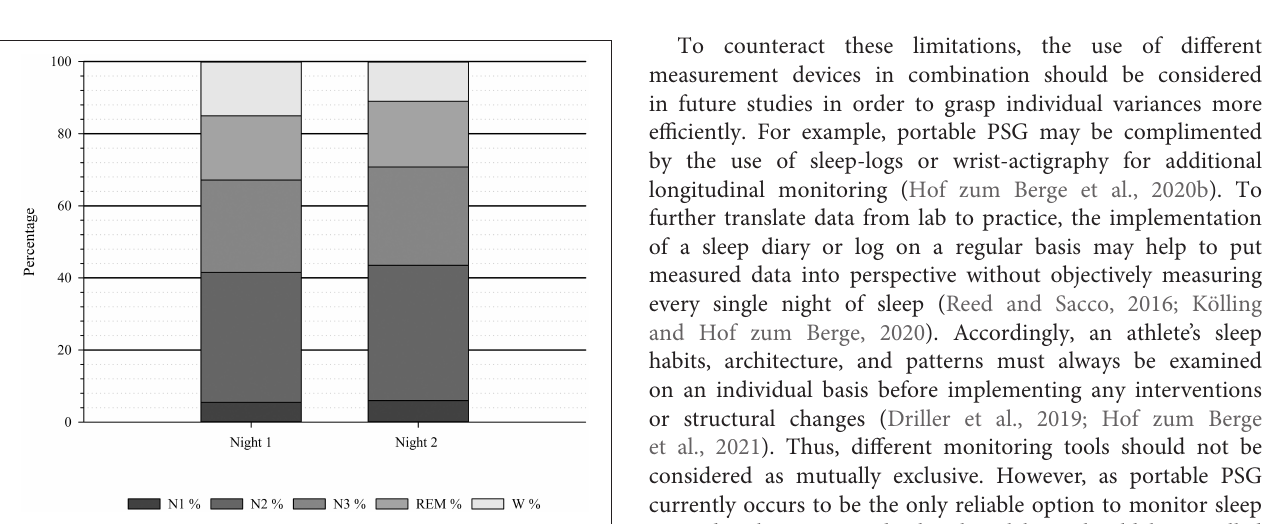
FIGURE 1 | Average sleep stage distribution ( N = 20). N, number of participants; N1, sleep stage 1; N2, sleep stage 2; REM, Rapid Eye Movement; W, Wake; %,